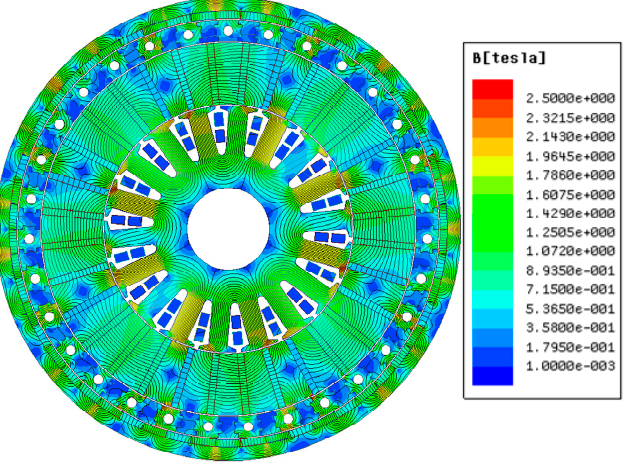
Figure 12. Flux density and field lines under full load with rated stator current.